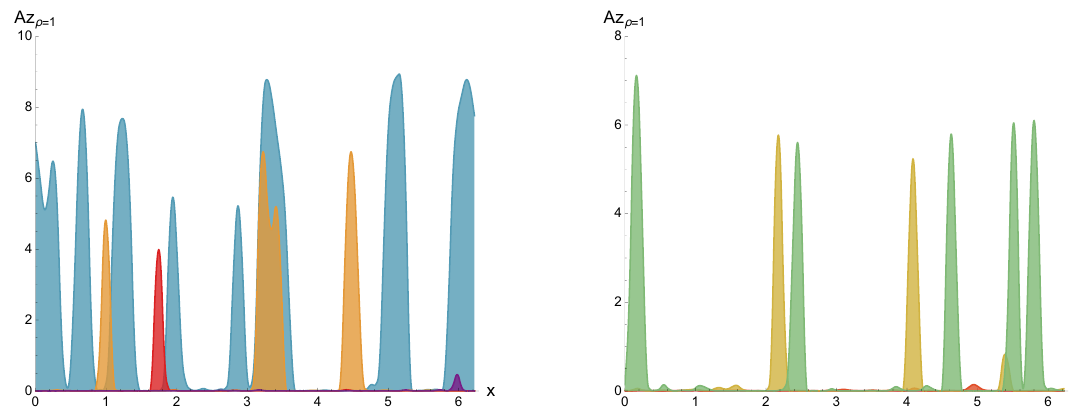
Figure 7 . The pro(cid:12)le of the gauge (cid:12)eld A z at the horizon and the appearance of the \rare" regions. Left: at (cid:12)xed disorder strength (cid:22) (cid:13) = 0 : 002 approaching the critical point. We take (cid:22) b 0 = 1 : 25 ; 1 : 3 ; 1 : 35 ; 1 : 4 (purple, red, orange, blue). Right: at (cid:12)xed (cid:22) b 0 = 1 : 35 and increasing